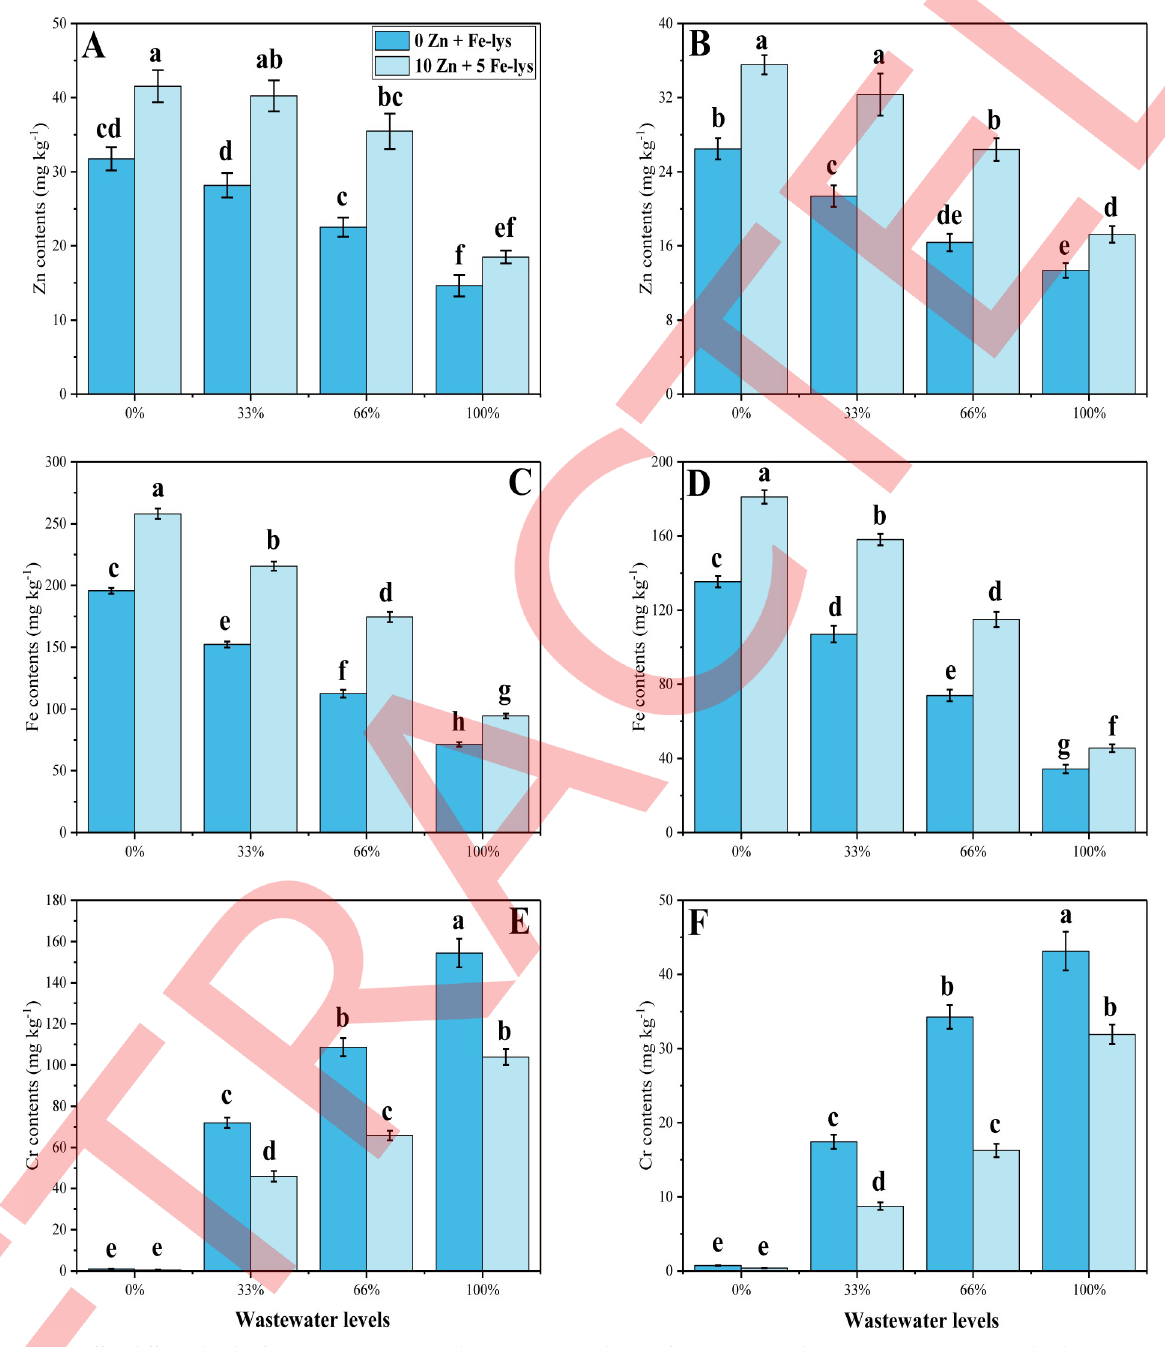
Fig 5. Effect different levels of tannery wastewater on the uptake/accumulation of Zn contents in the roots (A), Zn contents in the shoots (B) Fe contents in the roots (C), Fe contents in the shoots (D) Cr contents in the roots (E) and Cr contents in the shoots (F) under the application of Zn and Fe-lys on B . napus . Values are demonstrated as means of three replicates along with standard deviation (SD; n = 3). One-way ANOVA was performed and means differences were tested by HSD ( P < 0.05). Different lowercase letters on the error bars indicate significant difference between the treatments. Different levels of tannery wastewater used are as follow: 0 (without irrigation with wastewater), 33 (33% irrigation with wastewater), 66 (66% irrigation with wastewater) and 100 (100% irrigation with wastewater).